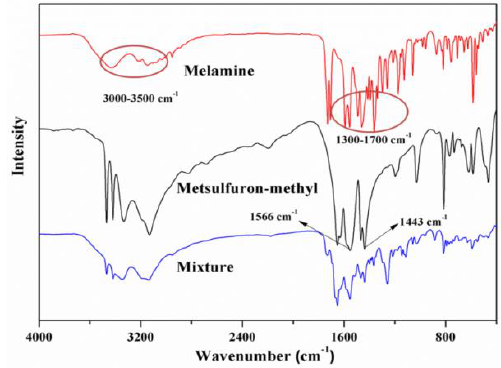
Figure 3. Fourier transform infrared spectrometer (FT-IR) spectra of the following: melamine, metsulfuron-methyl, and the complex of melamine and metsulfuron-methyl.